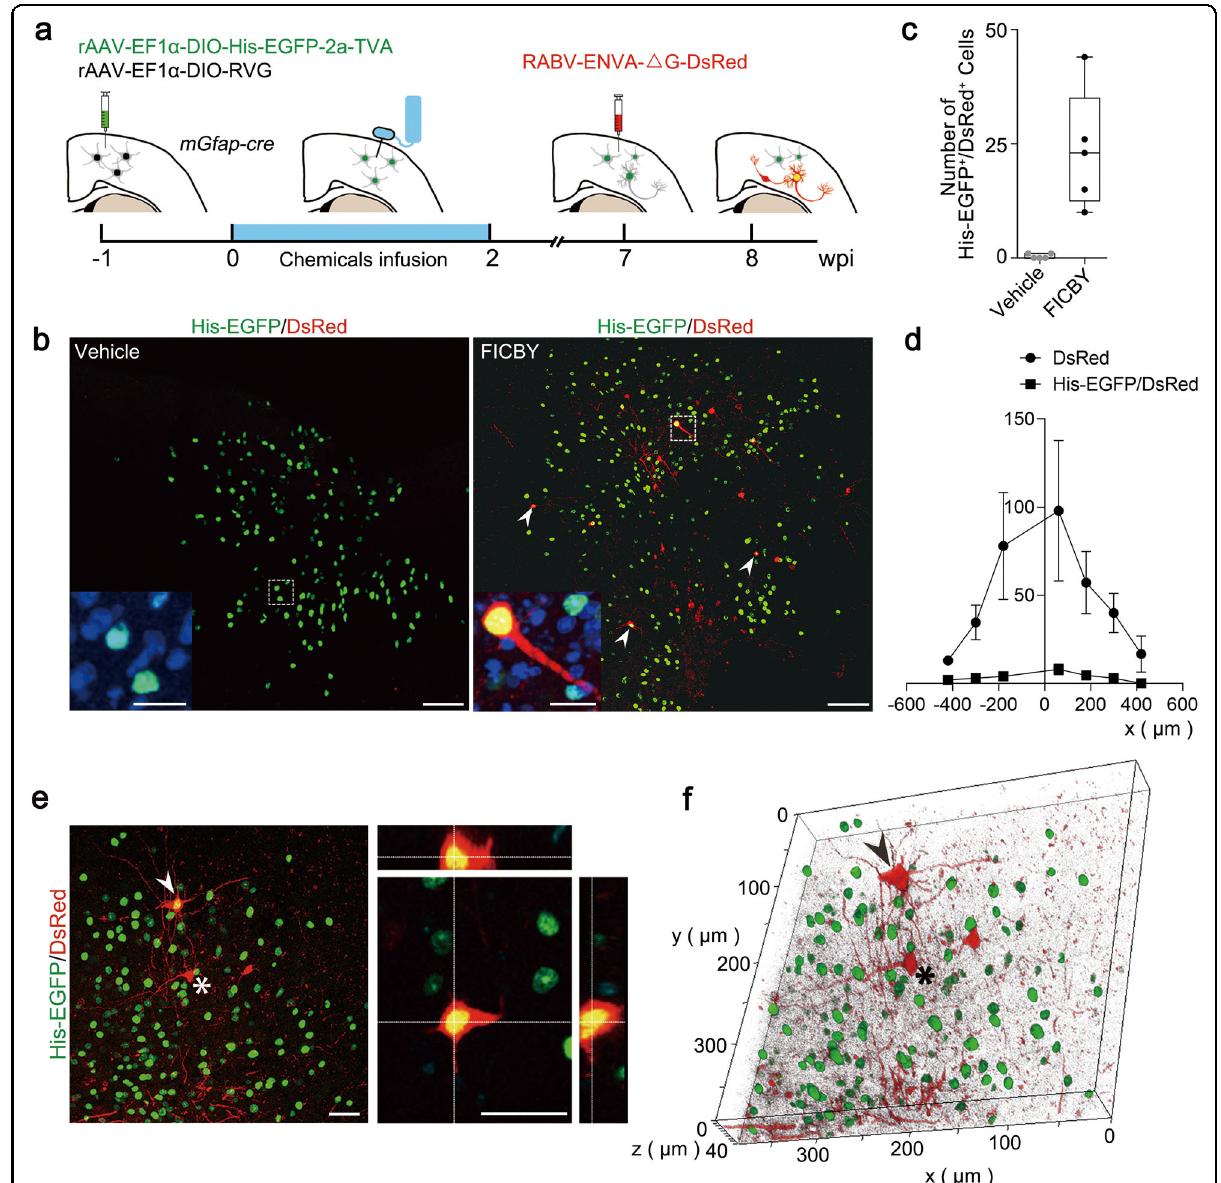
Fig. 4 Integration of in vivo reprogrammed CiNs into the mouse brain. a Schematic representation illustrating the RABV-based retrograde transsynaptic tracing process. b Illustrative images of the initiating astrocytes (green), CiNs (yellow nucleus and red cytoplasm) and traced host neurons (red) in the chemically induced and vehicle groups at 8 wpi. Arrowheads point to the examples of the CiNs. High-magni fi cation panels represent the co-localization of His-EGFP and DAPI. c Histogram representing the total number of His-EGFP + /DsRed + cells (CiNs) in the chemically induced and vehicle groups ( n = 5 mice). d Quanti fi cations of His-EGFP + /DsRed + CiNs and the connecting DsRed single-positive neurons across the injection area in the cortex ( n = 4 mice). e Illustrative fi gure of the His-EGFP + /DsRed + CiNs and the connecting DsRed single-positive neuron. White arrowhead points to a CiN, and the asterisk highlights a local neuron showing direct synaptic connections with the CiN. f The three-dimensional reconstruction of the image in e (left). The arrowhead and asterisk point to the same cells in e . Scale bars, 100 μ m; 20 μ m in high-magni fi cation ( b ); 40 μ m ( e ). Error bars represent